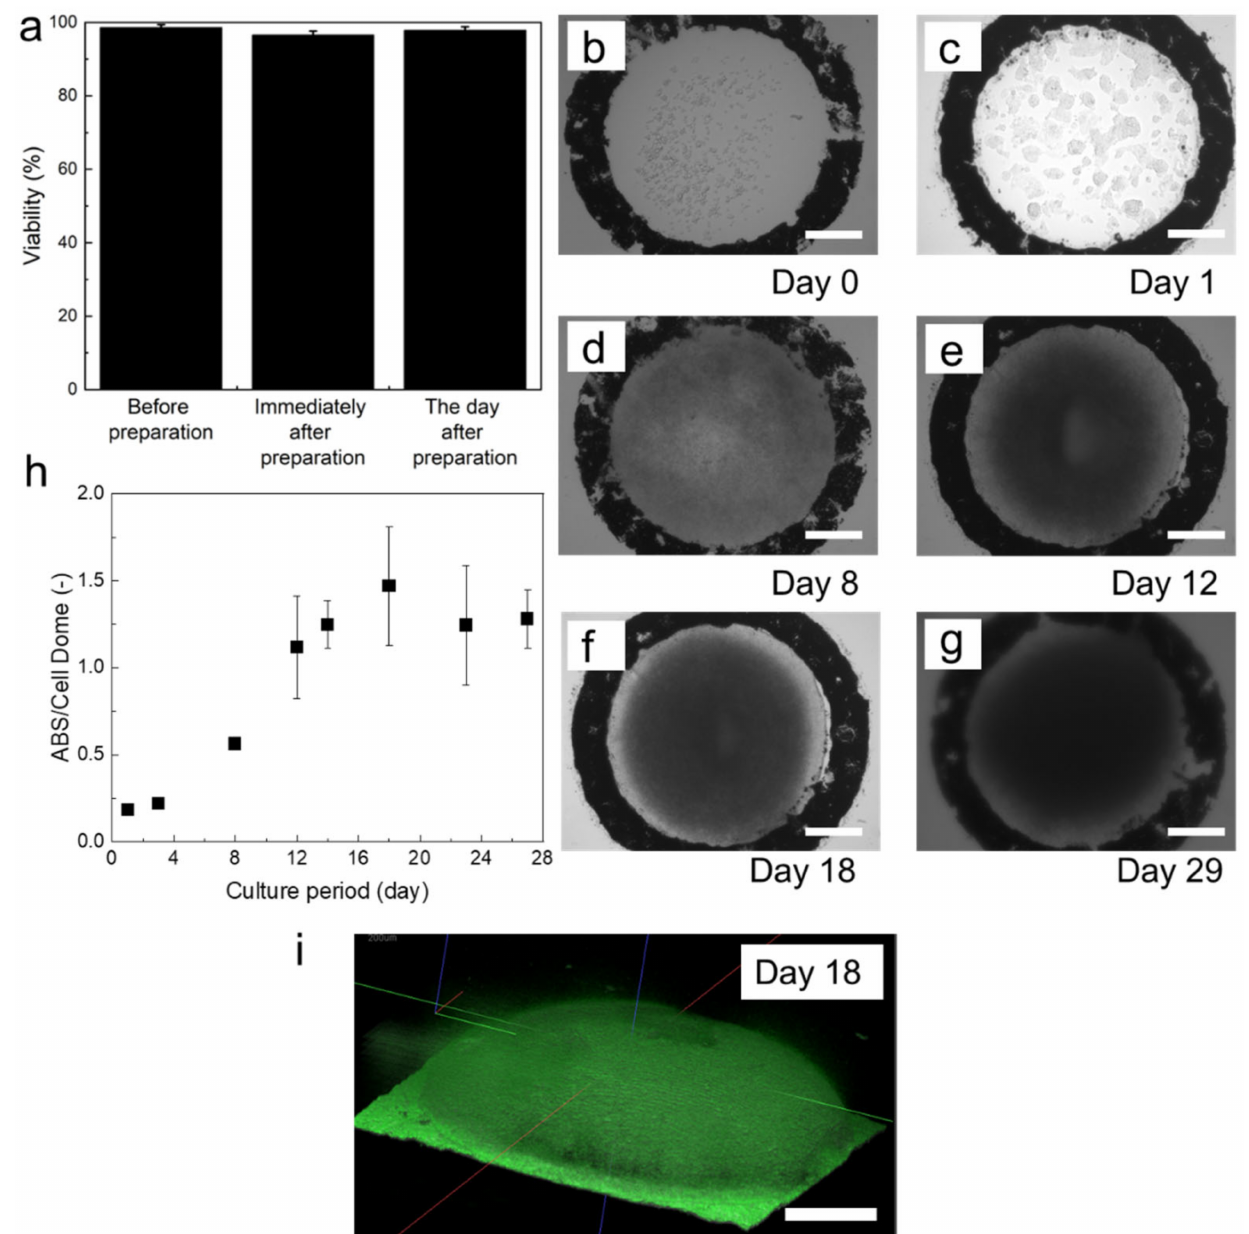
Figure 2. ( a ) HepG2 viabilities before enclosing and, immediately and a day after enclosing. ( b – g ) HepG2 cell growth in Cell Dome, ( h ) the mitochondrial activity, corresponding to a num- ber of living cells per Cell Dome, ( i ) optical coherence tomography image of HepG2 cells after 18 days of culture. Bars in a and h: SD, n = 5, Bars in ( b – g ) and ( i ): 250 µ